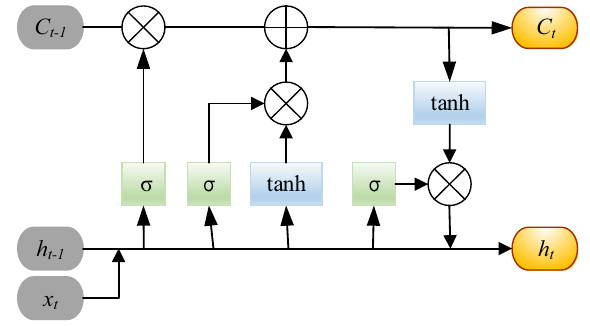
Fig. 2 The structure of LSTM circulation